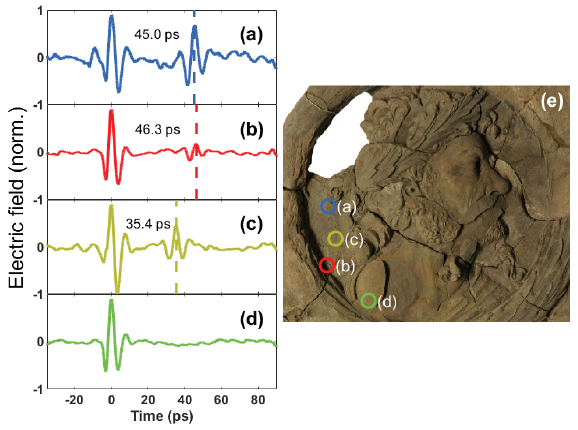
Figure 2. Panels ( a – d ) are the reflected terahertz pulses from various locations on the medallion, the positions that correspond to each measurement are marked on panel ( e ). It is easy to see that the area where points ( a – c ) lay presents an internal air gap that generates an echo 35ps to 45ps from the surface, which corresponds to a depth of 2.3mm to 3.4mm from the surface. The measurement at point ( d ) shows that the stone is solid and has no internal structure at that position